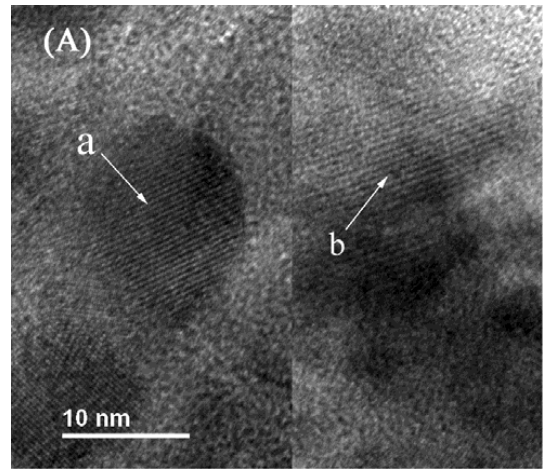
Figure 5. Cont. Figure 5. Cont.